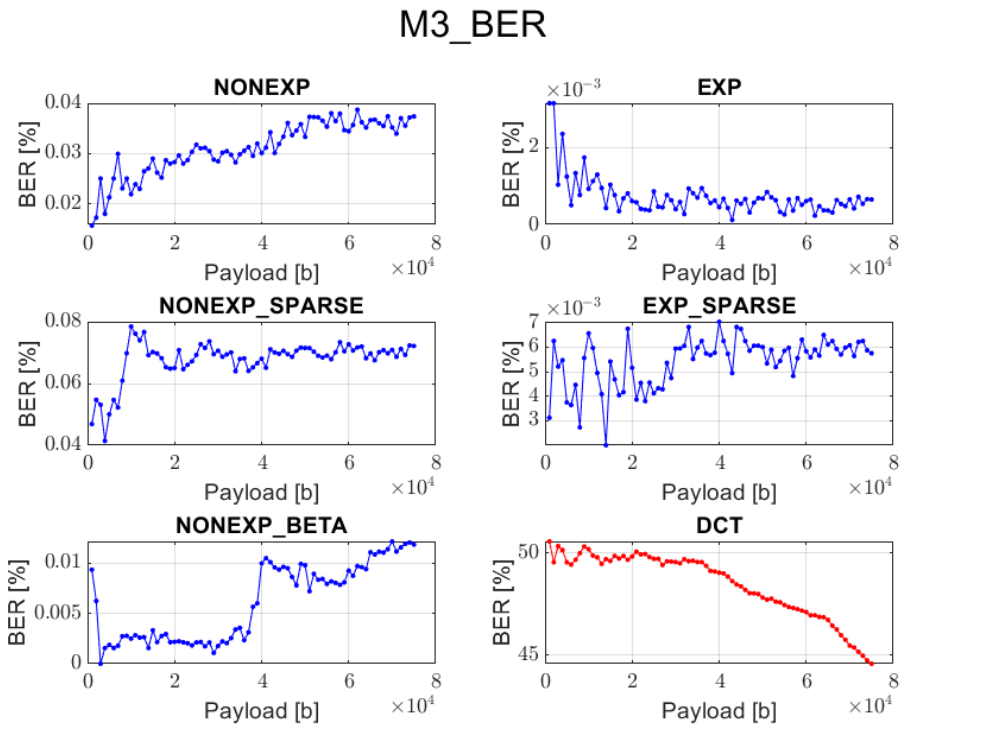
Figure 9. Relation between BER and embedded data size for method 3 and all transform